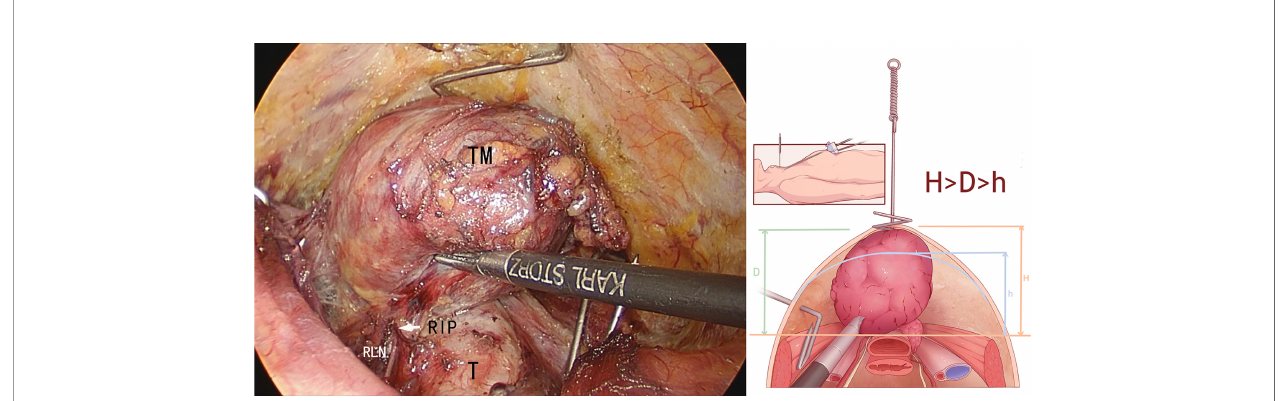
FIGURE 7 | Before the “ elastic stretch cavity builder ” lifts the skin fl ap, tumor diameter (D) was larger than the available height (h) (D>h), and the tumor could not be fully fl ipped to the opposite side. After the “ elastic stretch cavity builder ” is used to lift the skin fl ap, the expanded height (H) is larger than D and h (H>D>h), and the recurrent laryngeal nerve (RLN) inlet point can be fully exposed, making it possible for tumor resection. TM, thyroid tumor; T, trachea; RLN, recurrent laryngeal nerve; RIP, RLN inlet